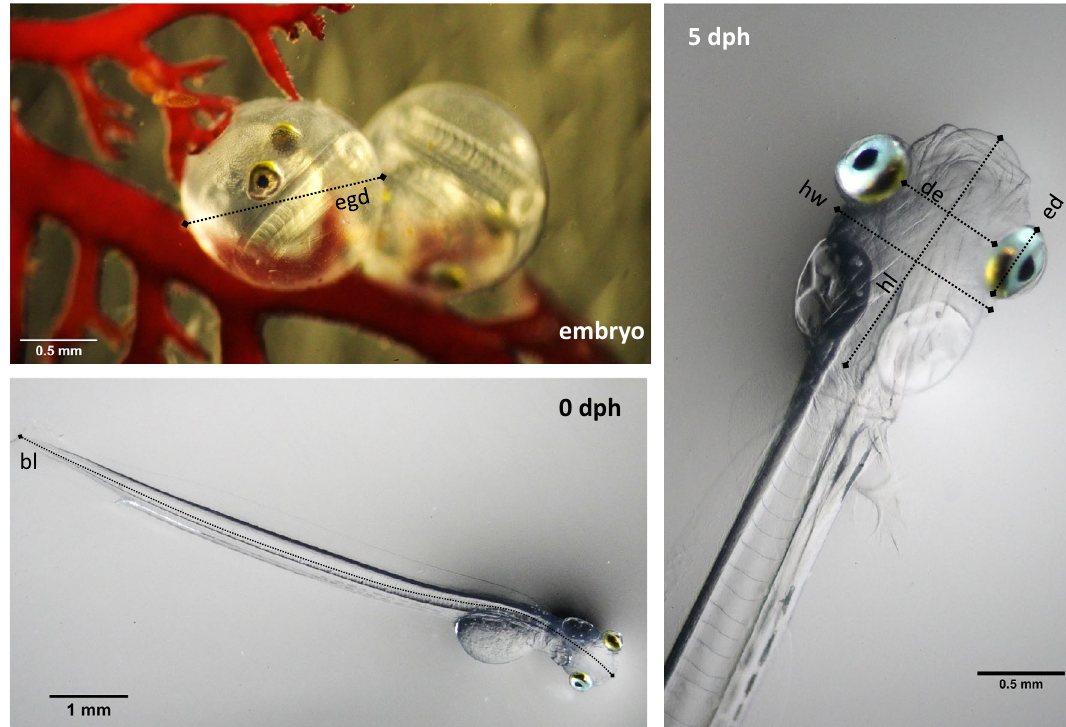
Figure 2. Morphology and measurements of embryonic and larval herring. Embryonic and larval herring: embryo at 6 days post fertilization (dpf; upper left panel) used for heartbeat frequency and egg diameter measurements, larvae at hatch (0 days post-hatch (dph); lower left panel) and 5 dph (right panel), used for length measurements, morphometrics and screening for cranial abnormalities ( egd egg diameter, bl body length, hw head width, hl head length, de distance between eyes, ed eye